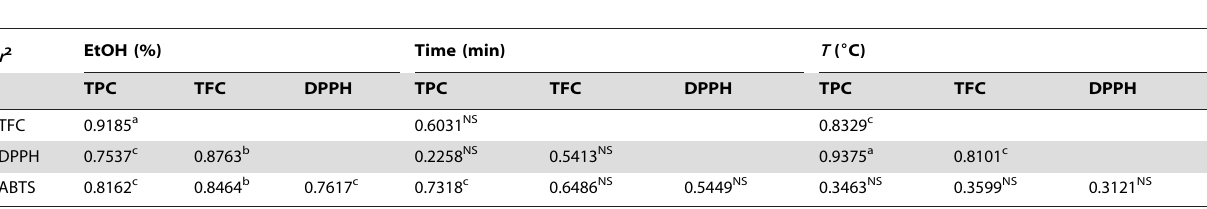
Table 4. Correlation between response variables under different extraction